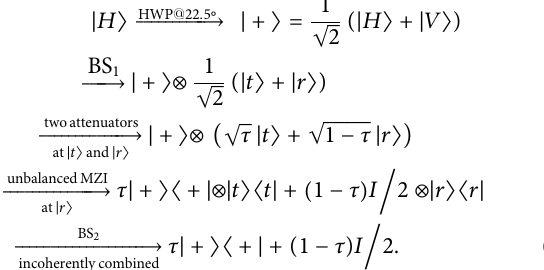
Figure 1B . The lower bound in QURs related to purity P CS is measured with CS algorithm. C J measurement on basis J , along with the measured purity. C J l ) is calculated with reconstructed ρ ( τ ). All the measurement f bases are realized with a HWP, a quarter-wave plate (QWP), and a